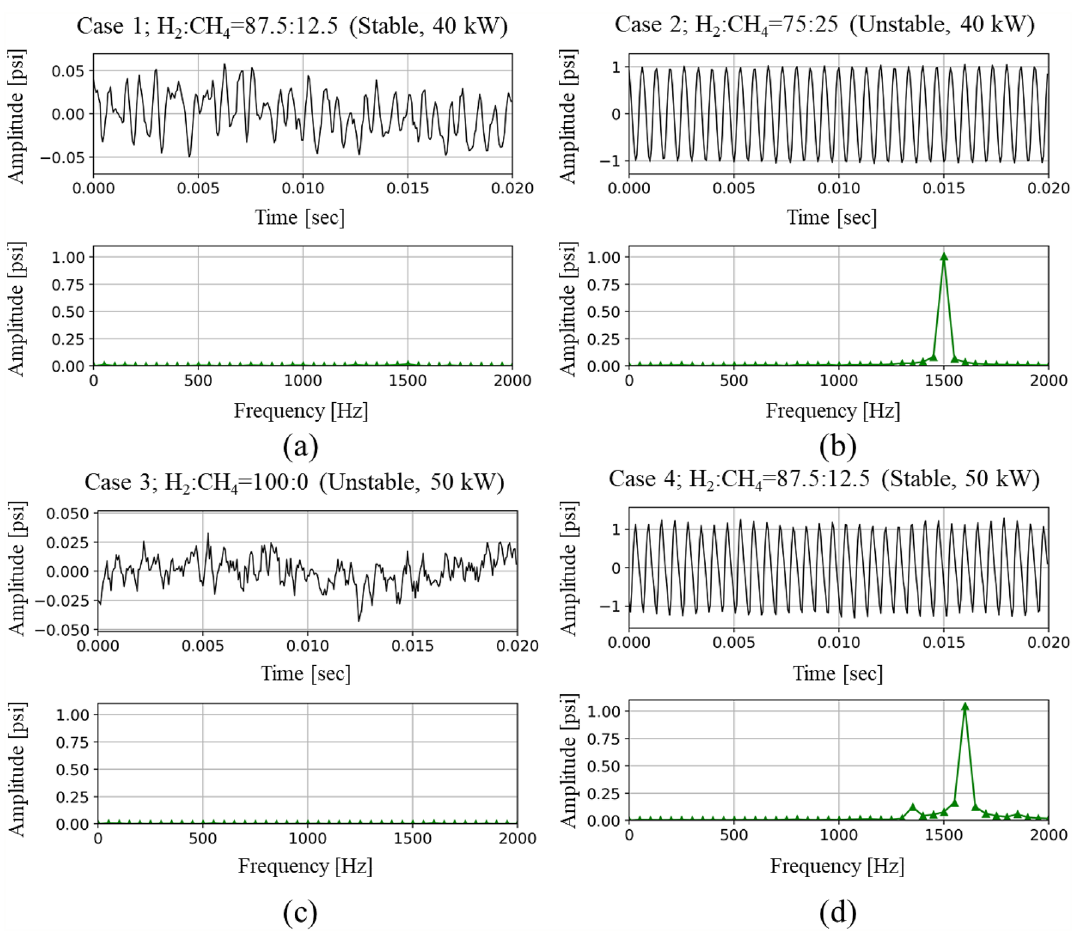
Figure 6. Dynamic pressure signal and FFT results (stable, unstable) for each fuel composition. ( a ) Case 1, ( b ) Case 2, ( c ) Case 3, and ( d ) Case